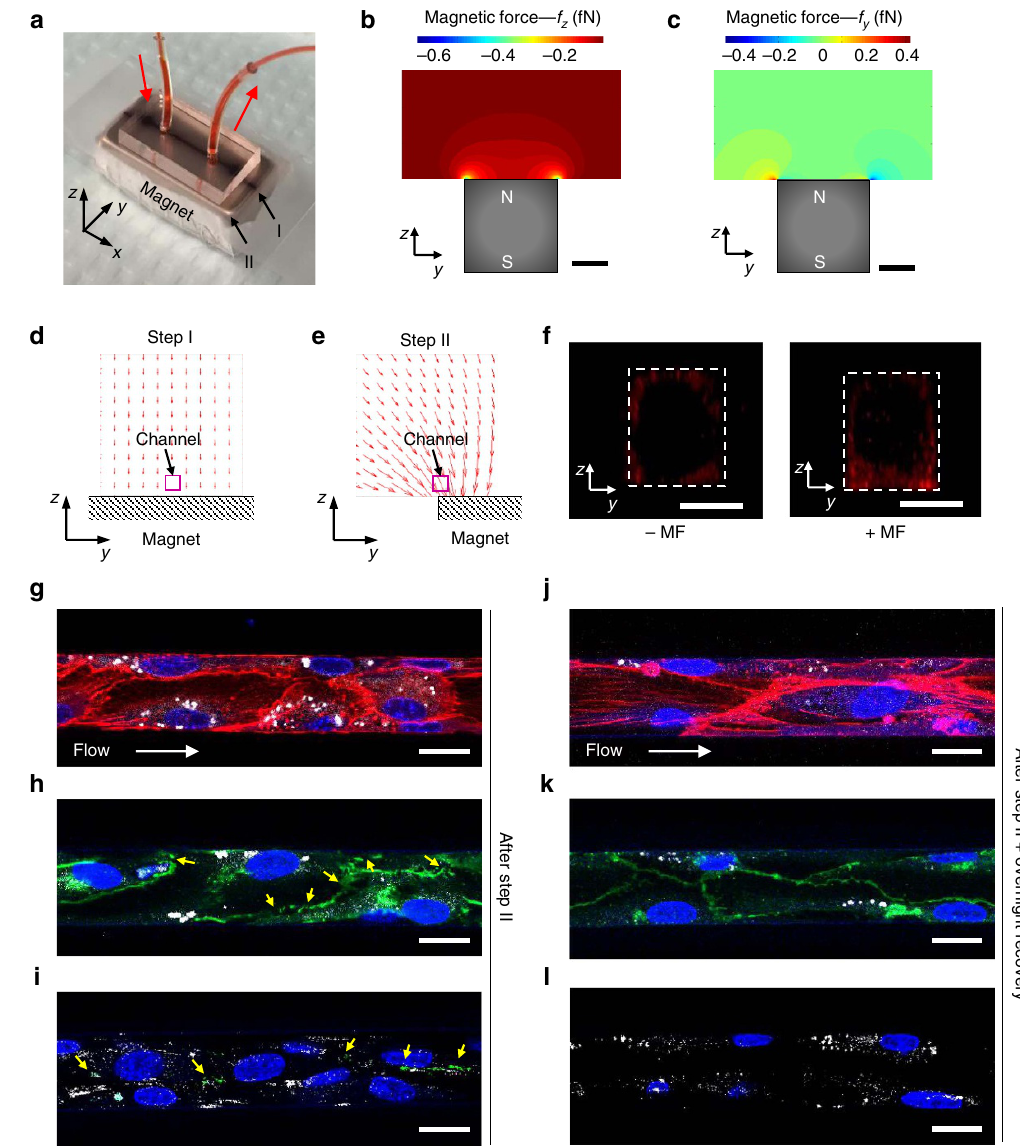
Figure 4 | The effect of magnetic force on the endothelium in vitro . ( a ) Macroscopic view of a microfluidic device placed on an N52-grade rare-earth magnet ( W (cid:3) H (cid:3) L ¼ 1/2 00 (cid:3) 1/2 00 (cid:3) 1 00 ). The midline of the magnet provides the reference for positioning the microfluidic channels in the magnetic field. The arrows indicate the flow direction. ( b , c ) Simulated distribution of magnetic force on MNPs in z and y directions. At the midline of the magnet, f z is large and homogeneous, while f y is negligible. f y and f z increase toward the edge of the magnet. Scale bar, 5mm. ( d , e ) The two-step magnetic treatment of the microfluidic channels and the corresponding force distribution. In step I, the microfluidic channel is aligned with the centre line of the magnet for 2h, while in step II, it is aligned with one edge of the magnet for 1h. ( f ) Representative confocal images of the cross-section of the endothelium following step I without or with the magnetic field. The magnetic force increased the uptake of MNPs by endothelial cells at the bottom of the channel. Dashed white lines mark the boundary of the channels. Scale bar, 20 m m. In step II, the endothelialized channels were moved to the edge of the magnet for 1h. After that, the endothelialized channels were either directly fixed and stained for actin and VE-cadherin, or cultured overnight under flow before staining. Immunostaining indicates that the two steps of magnetic force exposure led to disorganized endothelial actin filaments ( g , red) and disrupted adherens junctions ( h , green. Yellow arrows indicate the disrupted adherens junctions), while step I alone did not cause any change in actin organization (Supplementary Fig. 8). In addition, the vascular endothelium became permeable to antibody molecules as visualized by collagen I staining ( i , green). After overnight recovery without magnetic force, the endothelial actin filaments reorganized ( j , red) and the continuous adherens junctions were restored ( k , green). No collagen I staining was detectable, indicating the blockade of the endothelium to the antibody ( l , green). Blue, nuclei; white, MNP. Scale bar, 20 m forces described here will depend on the properties of the on endothelial cells is determined by the amount of intracellular nanoparticles, the flow rate in the vessels and the gradient MNPs, their size and the applied magnetic field. Previous studies generated at that point. In contrast to ultrasound-based methods, have shown that a focused magnetic field gradient can be magnetic fields are not attenuated by biological tissues, enabling generated at any location in the body 41,42 ; whether these gradients are sufficient for magnetic capture or to generate the better control of targeted delivery into deep tissue. In addition,